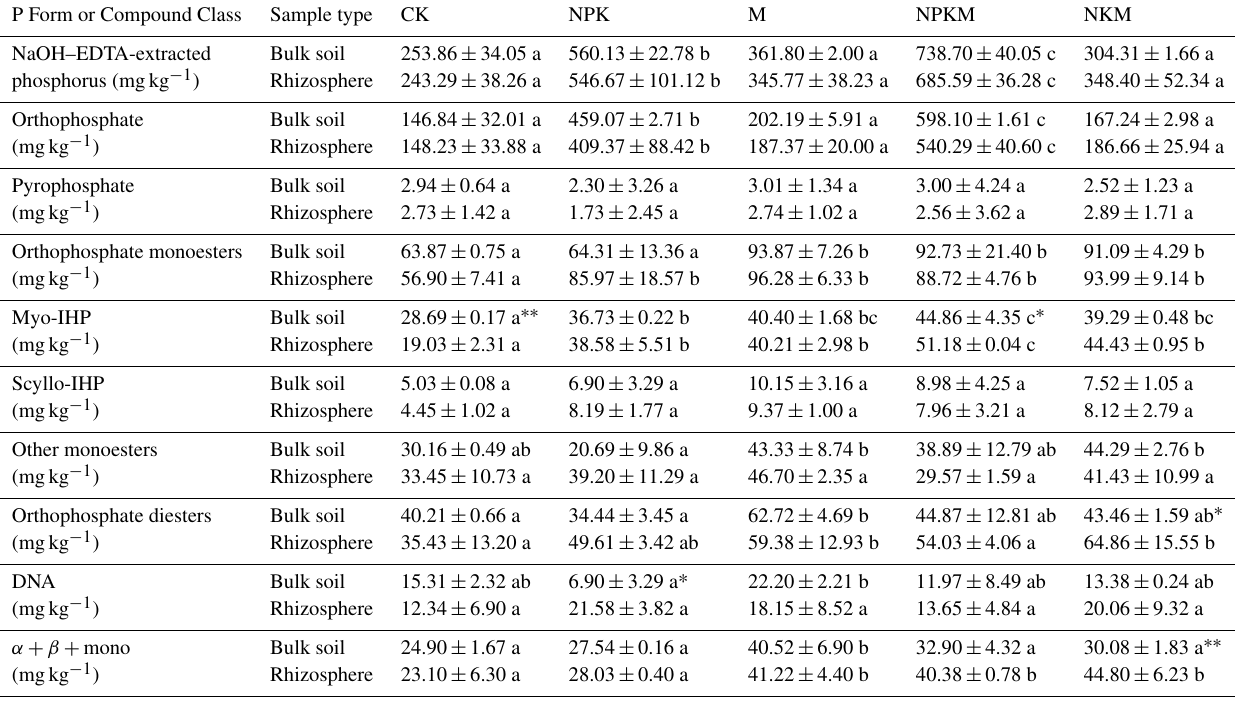
Table 2. The phosphorus species in five treatments (CK, NPK, M, NPKM, and NKM) and two sample types (bulk and rhizosphere soils). P Form or Compound